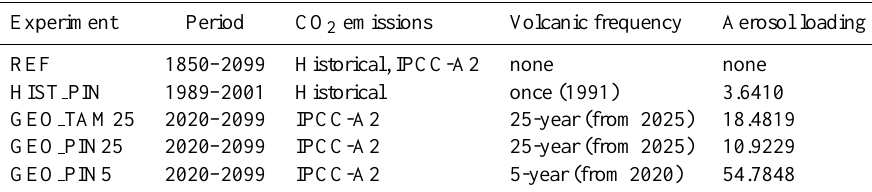
Table 1. List of the performed experiments with the period of integrations, CO 2 emissions, volcanic frequencies, and the integrated change in aerosol optical depth for each volcanic scenario.